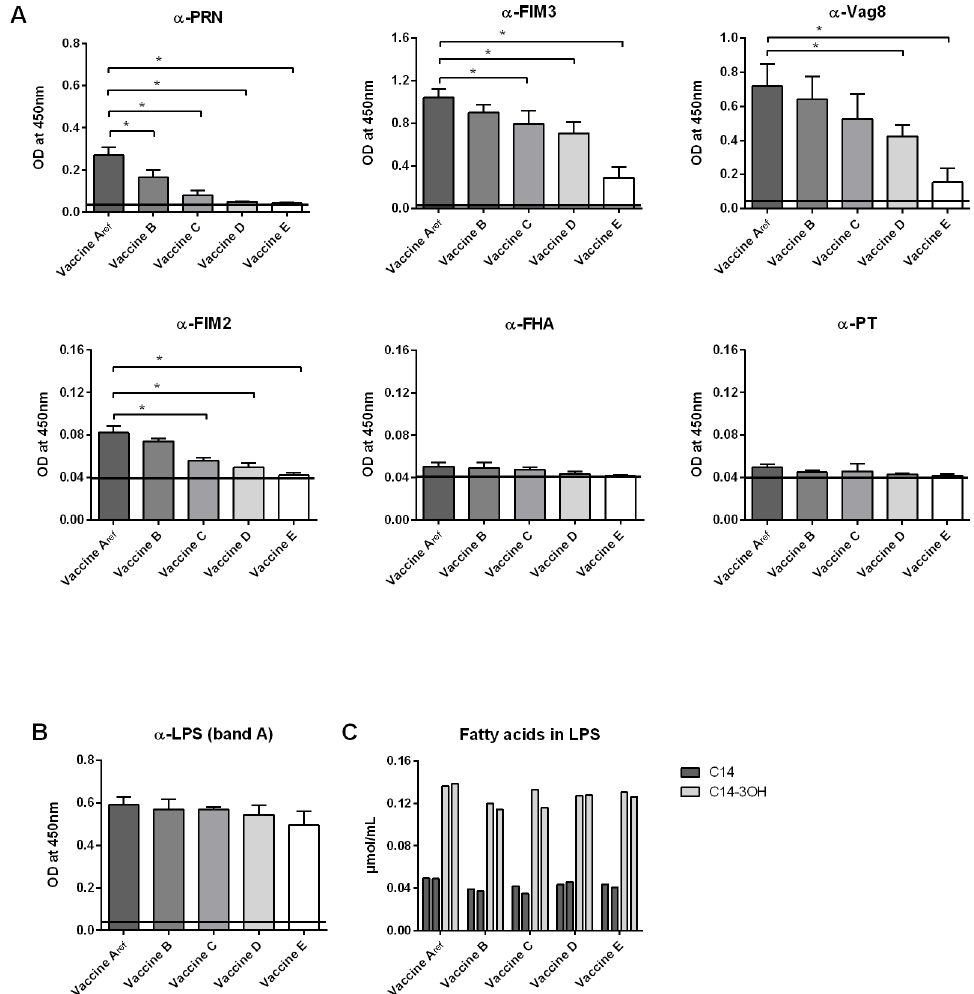
12, 24 hours after the addition of sulfate, respectively) derived from three individual B . pertussis culture runs were measured by ELISA using specific monoclonal antibodies directed against individual proteins or LPS. (C) Fatty acid composition of vaccines A ref , B, C, D, and E analysed using a modified gas chromatography method (in duplicate). The black lines indicate the background levels measured in PBS only by ELISA. * = p <